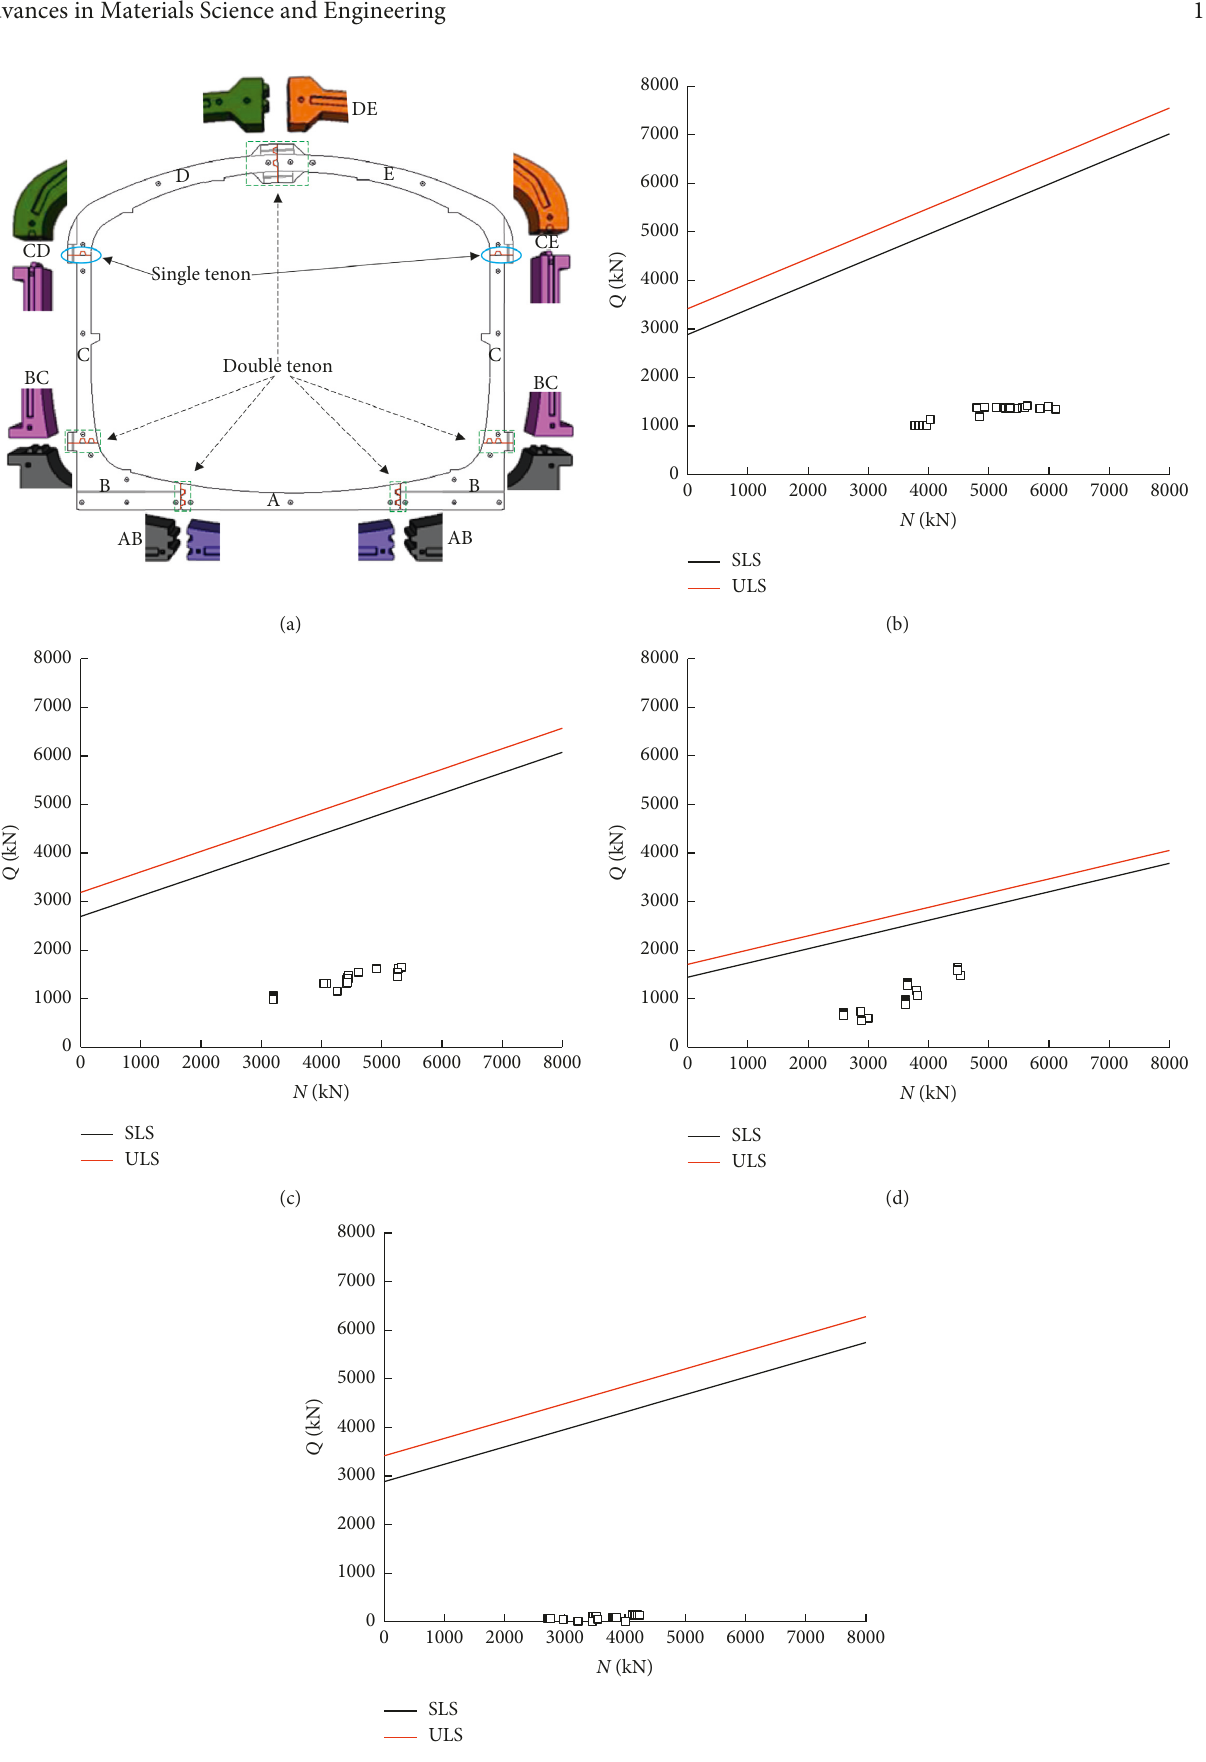
Figure 16: Checking calculation of shear capacity. (a) Distribution of all kinds of joint. (b) AB. (c). BC. (d) CD/E. (e)